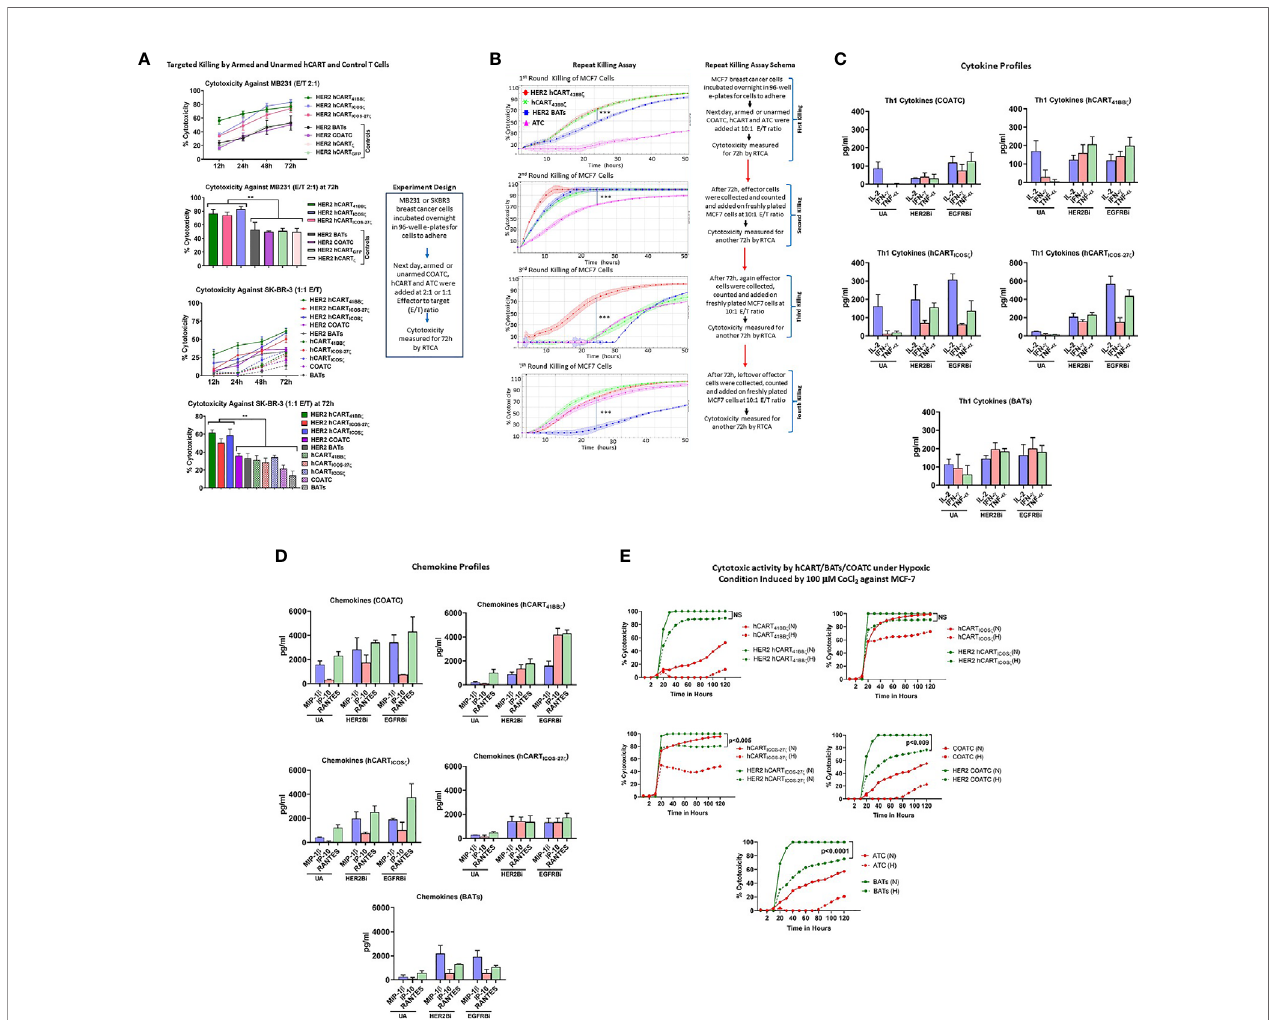
FIGURE 2 | (A) Speci fi c Cytotoxicity by hCART Transduced with Different Vectors. Upper panel showing speci fi c cytotoxicity by Headless CAR T cells (hCART) transduced by different constructs against MB231 from 12 to 72 hours at E:T of 2:1 using the real time cell analysis (RTCA) by xCelligence System (n=4, each condition had 3-4 replicates). The statistical analysis at 72 hours show signi fi cantly high speci fi c cytotoxicity by HER2 bispeci fi c antibody armed hCART 41BB z (HER2 hCART 41BB z ; p<0.008), HER2 hCART ICOS z (p<0.003) and HER2 hCART ICOS-27 z (p<0.009) compared to controls-HER2 hCART z , HER2 hCART GFP , HER2 bispeci fi c antibody armed co-activated T cells (COATC) and HER2 bispeci fi c antibody armed T cells (BATs) against MB231 cells (n=3, each condition had 4 replicates). Data is presented as mean ± SD of 4 replicates overtime and analyzed using Two-way ANOVA and Turkey ’ s multiple comparisons test. Lower panel shows the kinetics of cytotoxicity against SKBR3 cells by HER2Bi armed hCART, COATC, BATs and unarmed hCART, COATC and ATC controls from 12-72 hours. At 72h, speci fi c cytotoxicity was signi fi cantly high by HER2 hCART 41BB z (p<0.001), HER2 hCART ICOS z (p<0.001), HER2 hCART ICOS-27 z (p<0.005) compared to HER2 COATC, HER2 BATs and unarmed hCART controls at E:T of 1:1 (n=4, each condition had 3 replicates). Data is presented as mean ± SD of 4 replicates overtime and analyzed using Two-way ANOVA and Turkey ’ s multiple comparisons test. (B) Serial Killing by hCART 41BB z and BATs. Shows speci fi c cytotoxicity (Mean ± SD) by HER2 bispeci fi c antibody armed hCART 41BB z (HER2 hCART 41BB z ), HER2 BATs, unarmed (without BiAb loading) hCART 41BB z (green) and ATC (pink) against MCF-7 cell line measured by RTCA up to 4 rounds of serial killing (n=3, each condition had 4-6 replicates). Each killing was monitored up to 50 hours at E:T of 10:1. HER2 hCART 41BB z in all four killing rounds showed signi fi cantly higher cytotoxicity (p<0.0001) compared to one or more effector cells. Right panel shows the schema for repeat killing assay. Data is presented as mean ± SD of 4 replicates overtime and analyzed using Wilcoxon matched-pairs signed rank test. (C) Quantitative Cytokine Pro fi les of Culture Supernatants from Target (SKBR3) and Effector cells Co-culture. Th1 cytokines IL-2, IFN- g and TNF- a in the culture supernatants are shown for unarmed (without BiAb loading) or armed with HER2Bi or EGFRBi hCART 41BB z , hCART ICOS z , hCART ICOS-CD27 z , COATC, ATC in the presence of target cells (SKBR3) co-cultures (n=2, each pooled from three replicates). Detailed statistical analysis is presented in Table S1 . (D) Quantitative Chemokine Pro fi les of Culture Supernatants. Shows the chemokine in the culture supernatant from same co-cultures described above. Detailed statistical analysis is presented in Table S1. (E) Effect of Hypoxia on Effector Cell Functions. Showing cytotoxic activity by unarmed and HER2Bi armed hCART, COATC, ATC under normoxic (N) and hypoxic (H) conditions induced by 100 µM CoCl 2 against MCF-7 cell line (n=3, each condition had 4-6 replicates). There were no signi fi cant functional difference found between normoxic (solid lines) and hypoxic (dashed lines) conditions on the cytotoxic effects of HER2 hCART 41BB z and HER2 hCART ICOS z against MCF-7 cells in long term (120 hours) killing assay. Cytotoxicity by BATs (p<0.0001), COATC (p<0.009) and headless CAR T cells with ICOS-27 z intracellular domain was signi fi cantly lower (p<0.005) under hypoxic condition compared to normoxia against MCF-7 cells. Data is presented as mean of 6 replicates overtime and analyzed using Wilcoxon matched-pairs signed rank test (***p < 0.0001, **p <